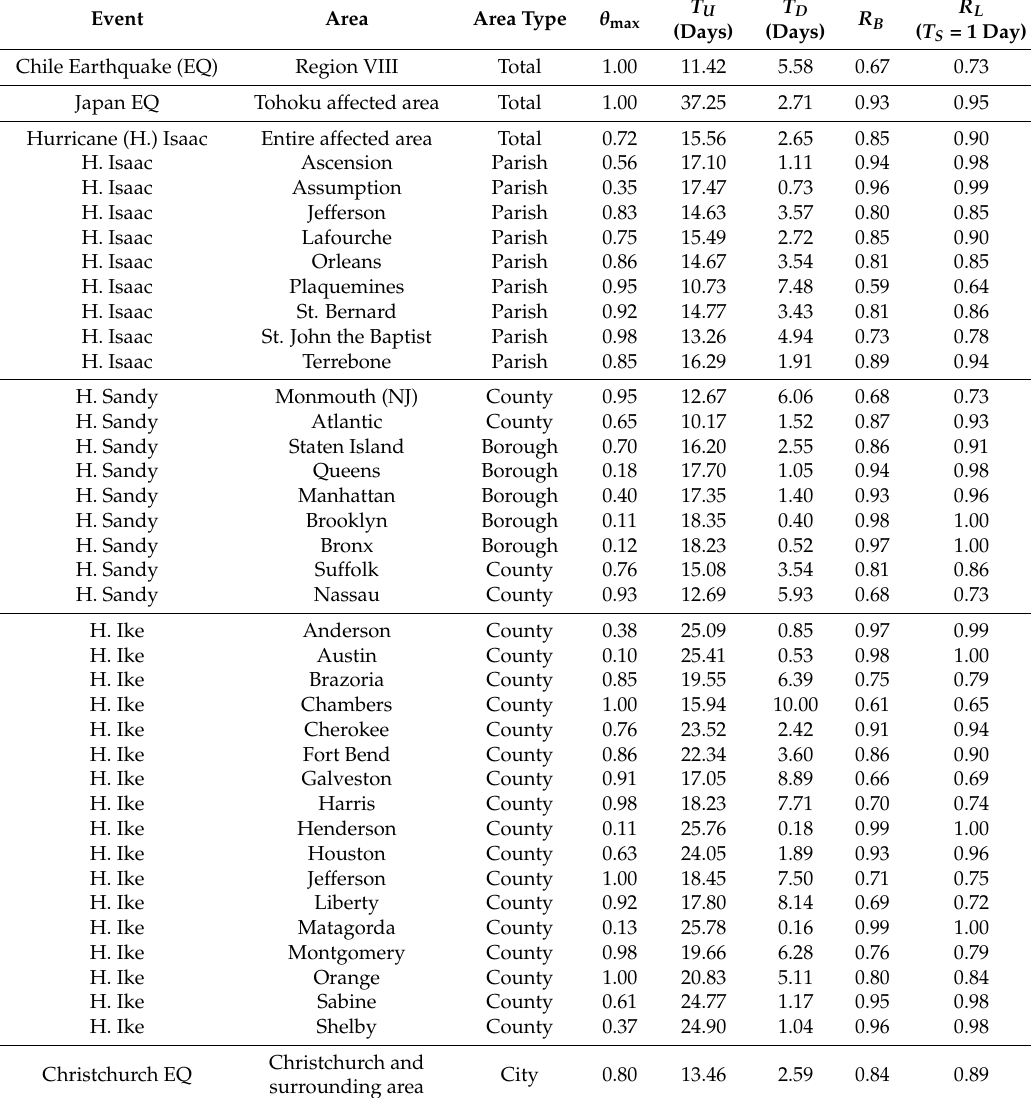
Table 1. Base and dependent resilience in various recent natural